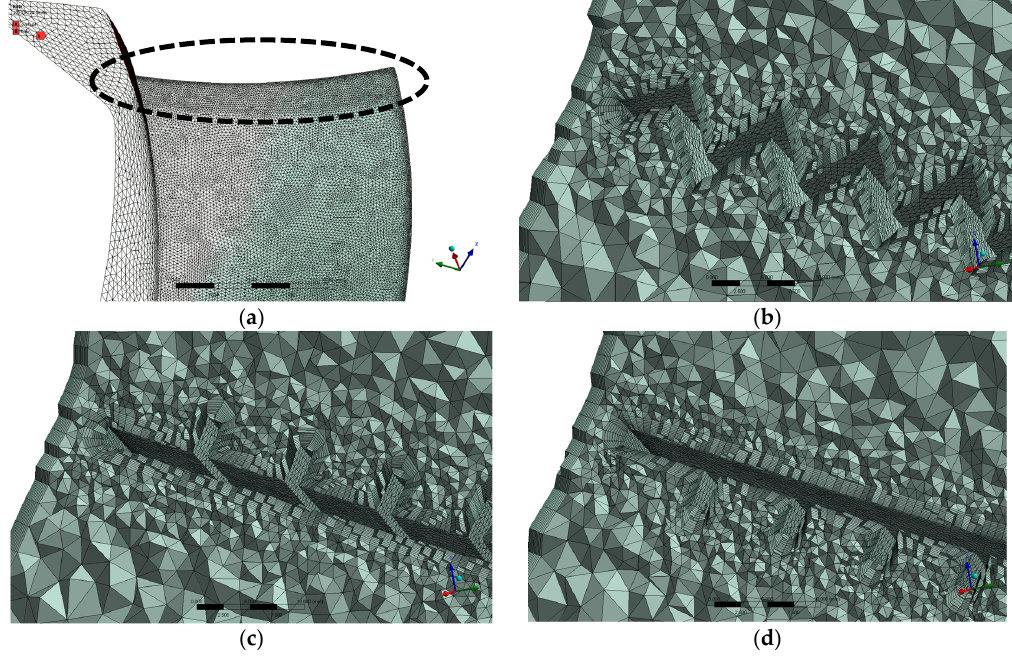
Figure 7. Grids of different blade forms: ( a ) Basic blade surface mesh, ( b ) Spanwise section mesh of the wavy blade, ( c ) Spanwise section mesh of the riblets on suction face blade, ( d ) Spanwise section mesh of the riblets on pressure face blade. The regions in the circle (leading-edge region) in ( a ) is refined with a grid size of 0.7 mm, which is applied to the other designs meshes as well. Table 3. Parameters and numerical results of three sets of mesh .